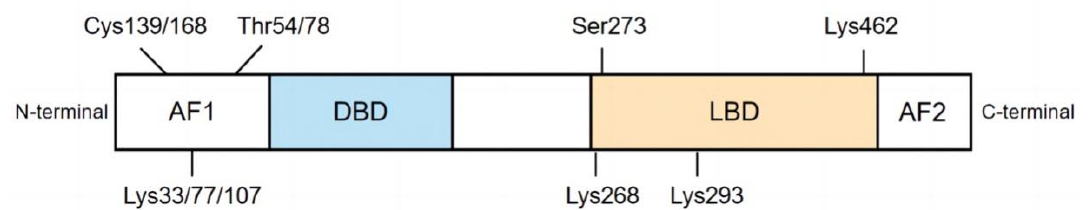
Figure 1. Structural characteristics and species conservation of PPAR γ . Schematic diagram of the PPAR γ protein structure includes the activation function 1 and 2 domains (AF1 and AF2), DNA binding domain (DBD), and ligand-binding domain (LBD).